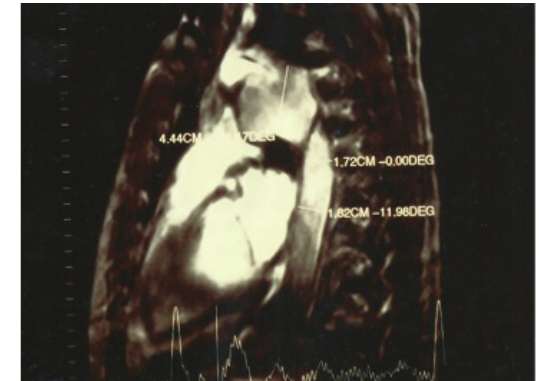
Figure 2: Angio MRI: Evidence of the relationship between the vas- cular intimal rupture post-traumatic descending thoracic aorta and the pseudo-aneurysm